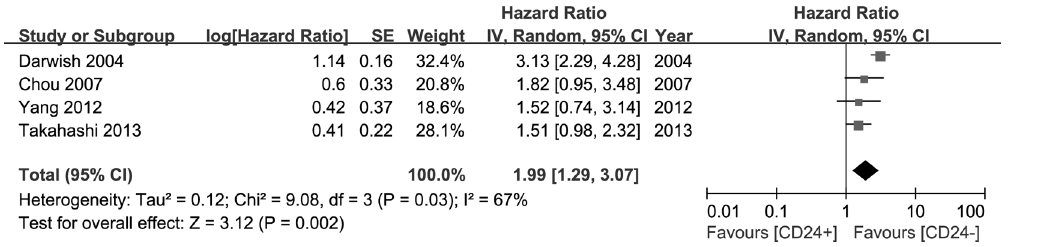
Fig. 3. Forest plot of hazard ratio for overall survival of patients with gastric cancer. The squares and horizontal lines correspond to the study- specific HR and 95% CI. The area of the squares reflects the study-specific weight (inverse of the variance). The diamonds represent the pooled HR and 95% CI. The solid vertical line is at the null value (HR 5 1). The pooled HR for OS showed overexpression of CD24 reduced OS in gastric cancer (HR 5 1.99, 95%CI 1.29–3.07, P 5 0.002).